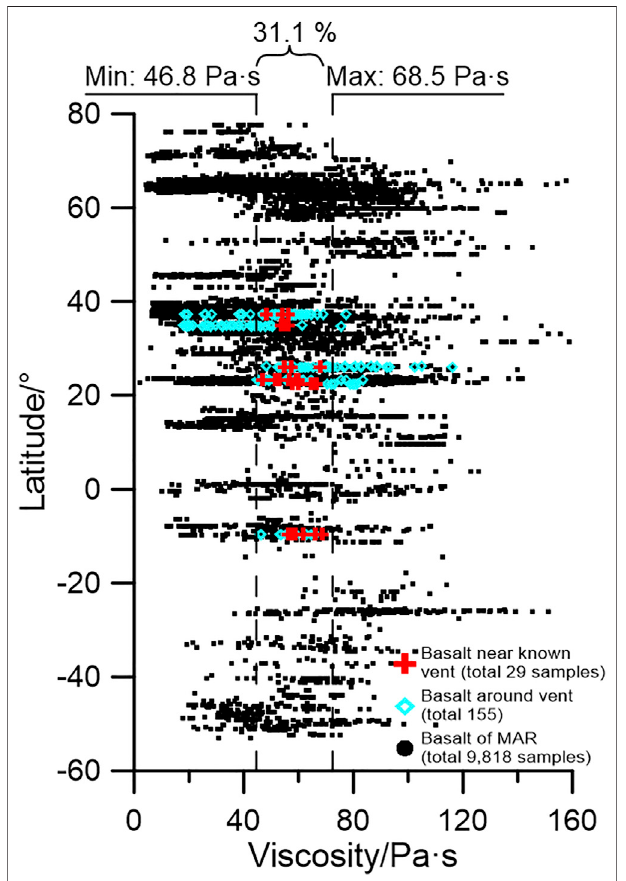
FIGURE 9 | BNV, BAV, and MAR basalt samples (distinguished by pink crosses, cyan diamonds, and black circles, respectively) plotted on a viscosity – latitude scatter diagram. All BNV and BAV, and MAR basalts with viscosities below 160 Pa · s (this excludes 20 samples with viscosities between 160 Pa.s and the maximum viscosity of 574 Pa · s) are shown.